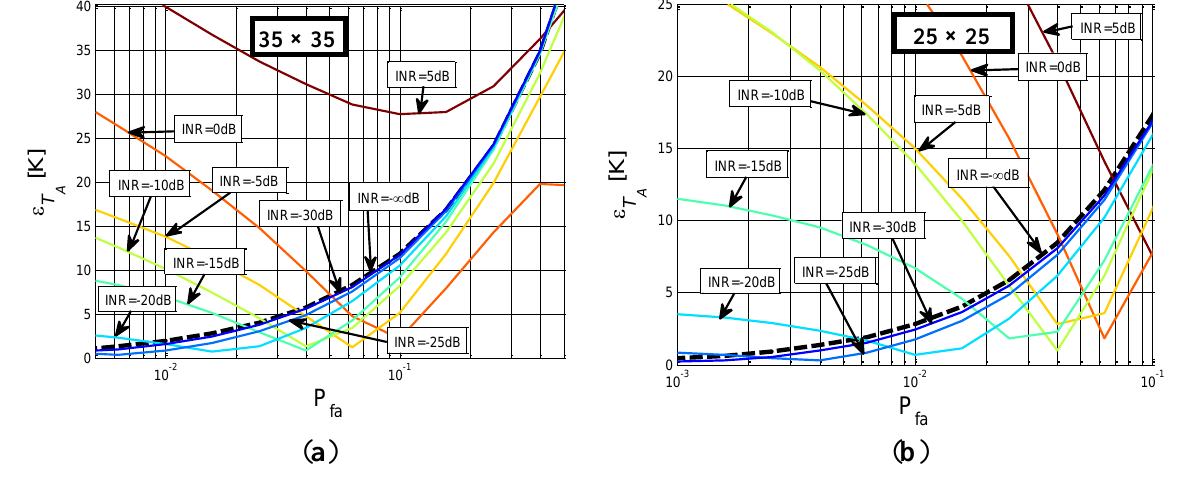
Figure 12. Error obtained by the Smoothing Algorithm in the retrieved T broadband PRN like signal, using a Hann window as smoothing filter. ( a ) 35 × 35 Hann window; ( b ) 25 × 25 Hann window; ( c ) 5 × 5 Hann window; ( d ) without using the Smoothing